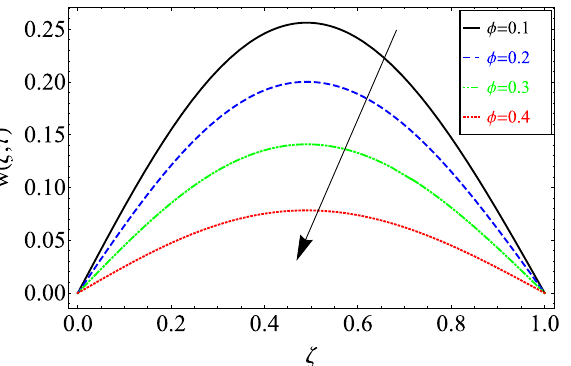
Figure 8. The effect of different value of φ on velocity distribution of Maxwell nanofluid, when α = 0.7 , τ = 0.5 , Sc = 15 , Gm = 0.5, Gr = 0.05 , Pr = 6300 , Re = 10 and (cid:31) = 0.5 .